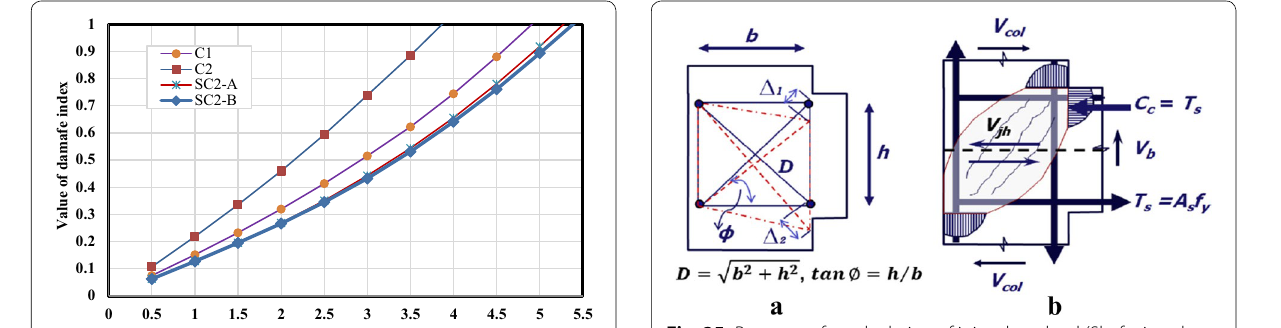
beam-column connections with/without HPFRCC. Dam- age index is defined equation by 3.